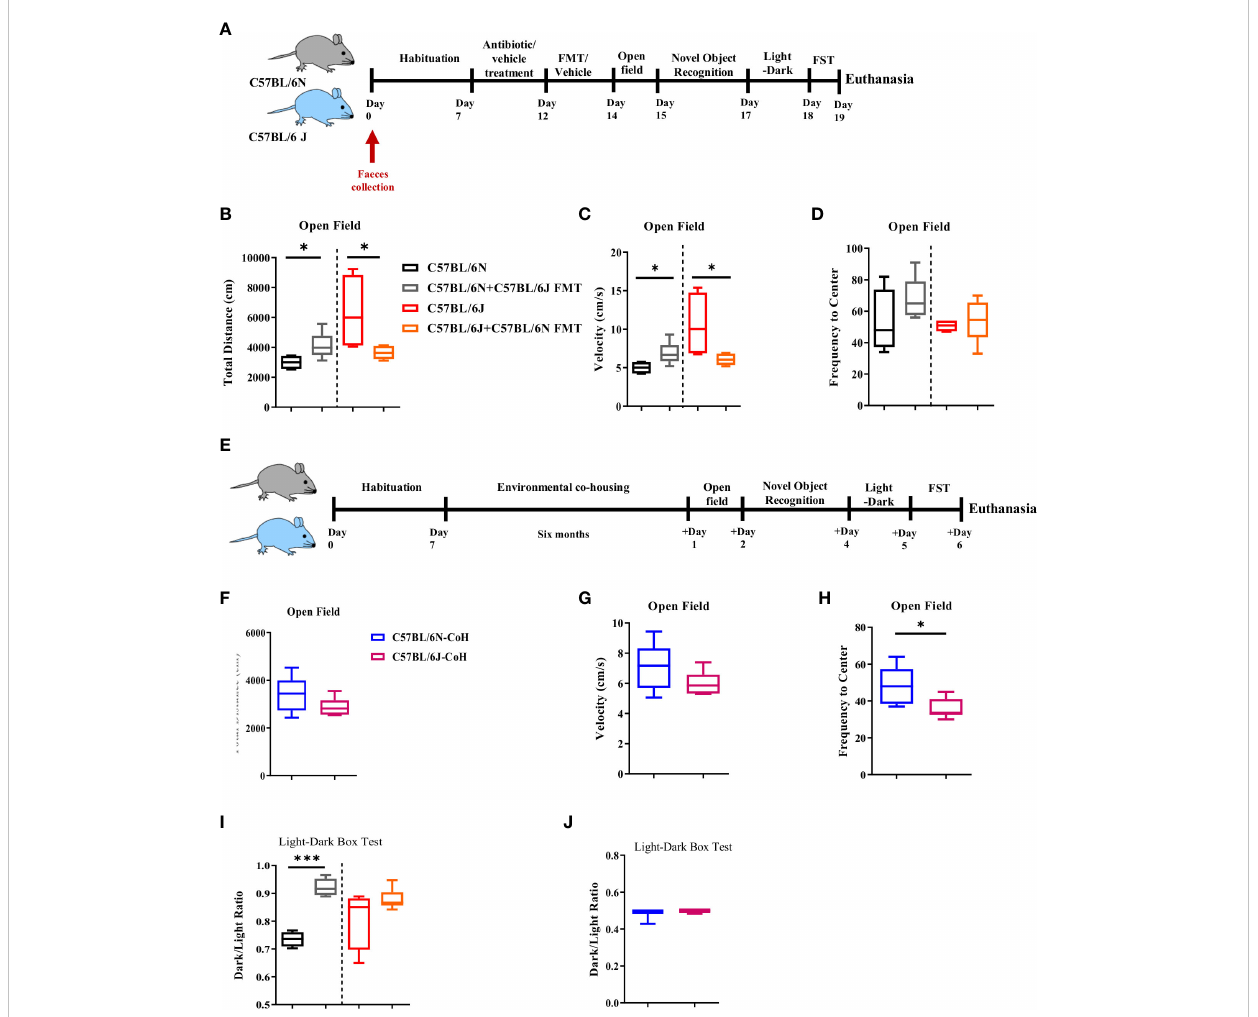
FIGURE 3 Microbial and environmental factors in fl uence locomotor activity of C57BL/6 sub-strains. (A) Experimental design set 2. Faeces were collected from C57BL/6N and C57BL/6J mice day 0. These mice were treated for 5 days with antibiotic cocktail for microbiome clearance. Faecal microbiota transfer (FMT) was then done through oral gavage. (B) Total distance travelled, (C) Velocity, and (D) Frequency to the centre in C57BL/6N and C57BL6/J upon FMT are depicted. (E) Experimental design set 3. In the third setup, C57BL/6N and C57BL/6J mice were environmentally co-housed for six months followed by an assessment of the affective and cognitive behaviors. (F) Total distance travelled, (G) Velocity, and (H) Frequency to the centre after long-term co-housing are depicted. (I) Dark-to-light ratio using light-dark box test was measured upon FMT, and (J) after long-term co-housing. Results are representative of two independent experiments with 5 – 7 mice/group. Data are expressed as mean ± S.E.M. *P < 0.05, ***P < 0.0001 by two-tailed unpaired Student